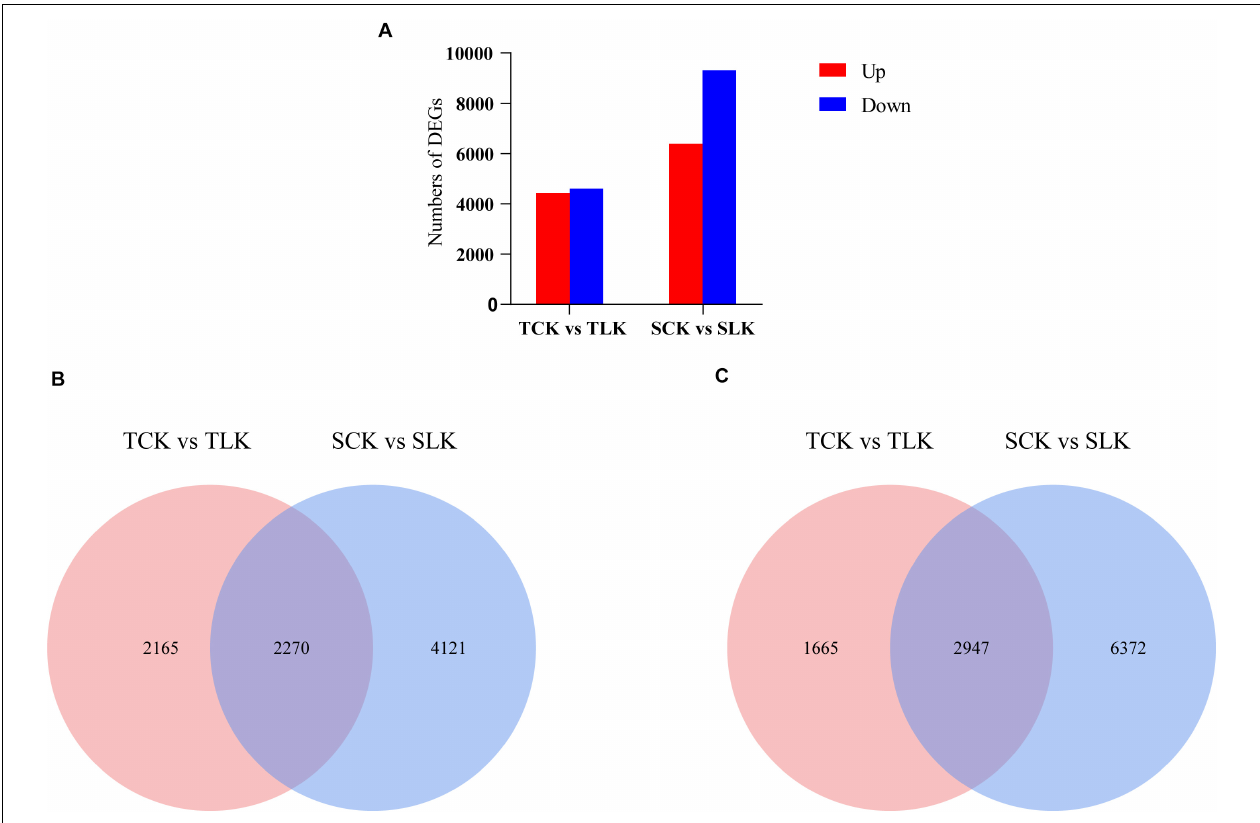
FIGURE 2 | Overview of the transcriptomic analysis. (A) Differentially expressed genes. (B) Venn diagram for the up-regulated DEGs after the low-K treatment of KN9204 and BN207. (C) Venn diagram for the down-regulated DEGs after the low-K treatment of KN9204 and BN207. TCK, KN9204 after the control potassium treatment. TLK, KN9204 after the low-K treatment. SCK, BN207 after the control potassium treatment. SLK, BN207 after the low-K treatment.